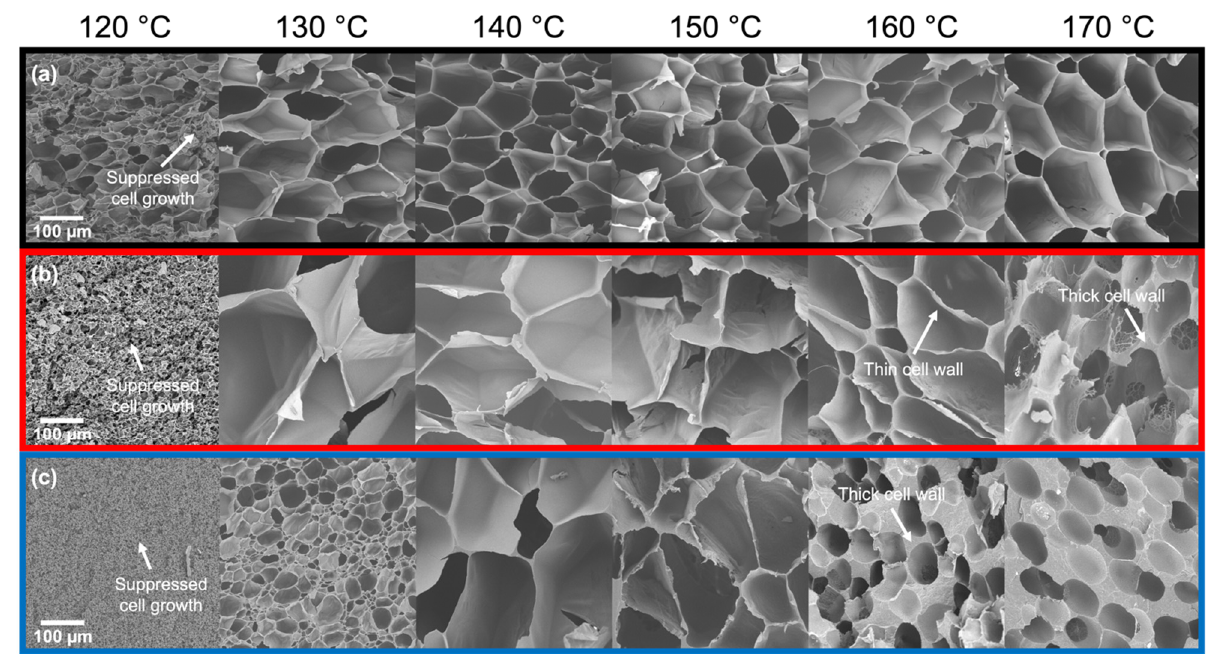
Figure 7. SEM images of ( a ) Resin A, ( b ) Resin B, and ( c ) Resin C foams produced using Method 2 (i.e., complete melting of PP followed by supercooling). Onset crystallization temperatures of the resins are 109 °C, 117 °C, and 118 °C, respectively.